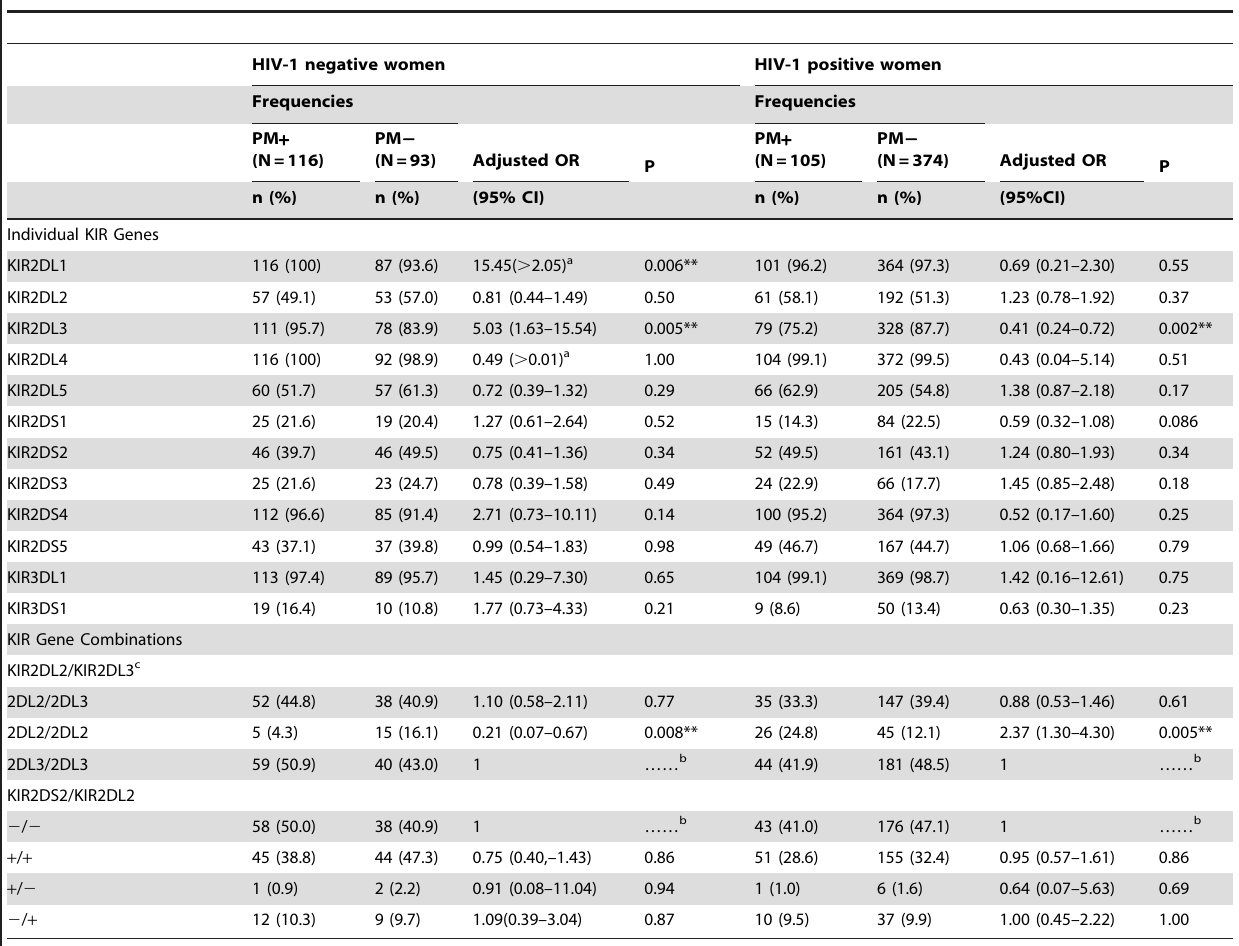
Table 2. Adjusted Odds ratios for individual KIR genes and KIR gene combinations in HIV-1 negative and HIV-1 positive women, outcome placental malaria (PM)